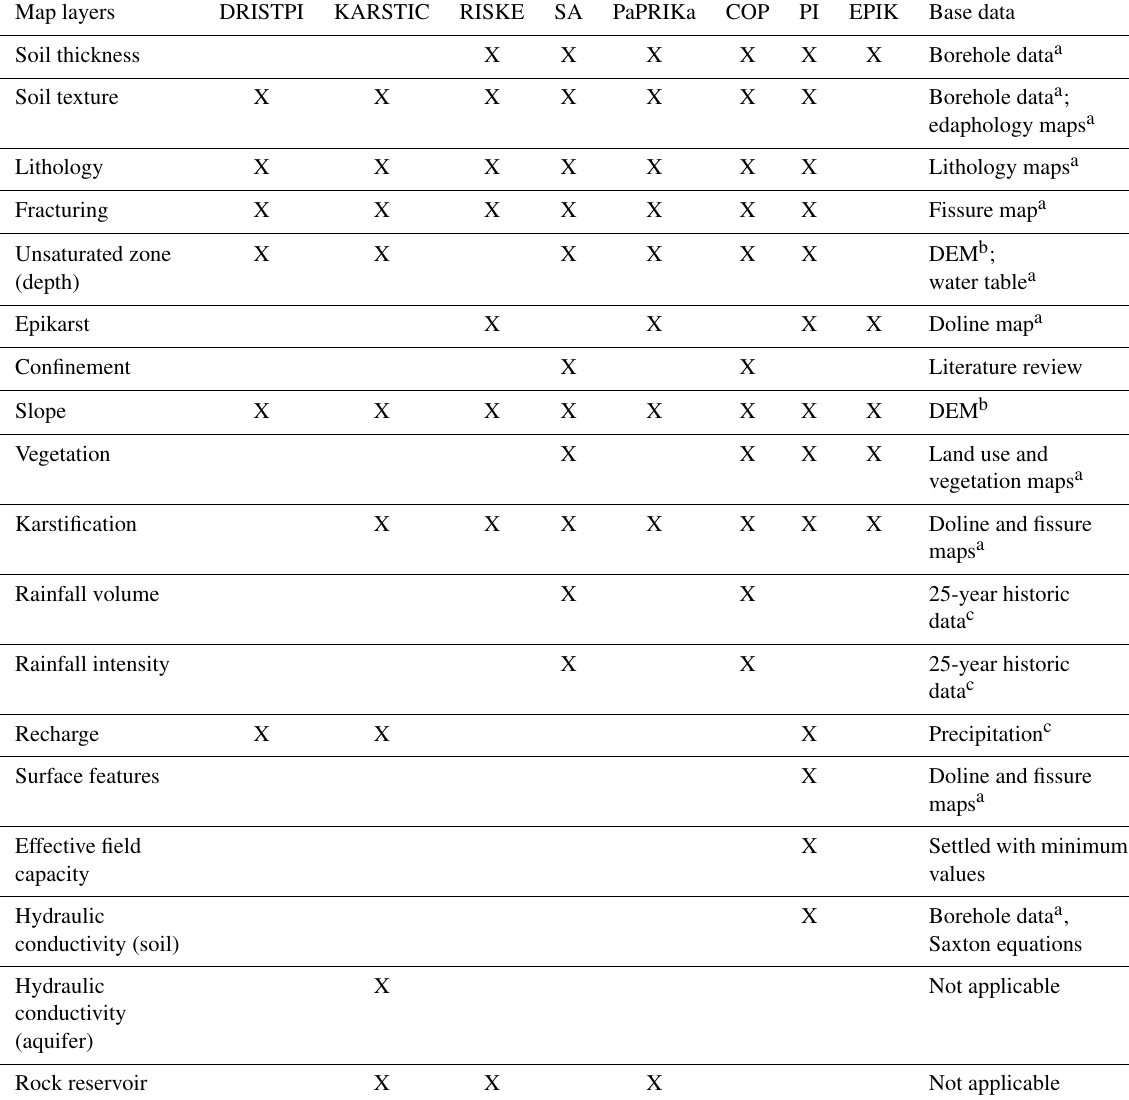
Table B1. Data gathered for the development of previous vulnerability maps in Yucatán. Reproduced from Moreno-Gómez et al. (2019). Map